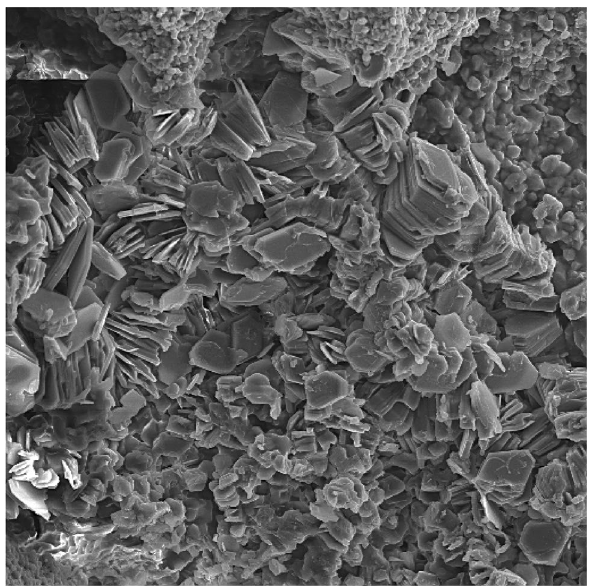
Fig. 5 SEM image of kaolinite flakes attached to pore walls of core no.1